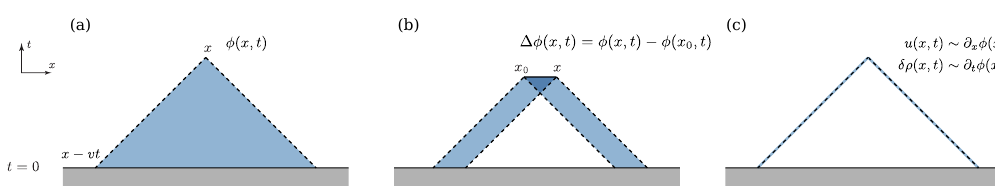
Figure 14: Schematic explanation of the equilibration time scaling in the canonical transmutation mechanism. Due to the linear dispersion of the TLL liquid, the phase field propagates according to the wave equation, meaning that it depends on initial data in the interior of the past light-cone (a). However, the phase field is not a physical observable itself: It is only phase differences with respect to some reference ) (b) or derivatives of the phase field (c) (corresponding point ∆ φ ( x ) = φ ( x ) − φ ( x 0 φ and density field δ ˆ (cid:37) ∼ ∂ φ ) that to the hydrodynamic fields like the velocity ˆ u ∼ ∂ z t are well-defined observables. The propagation of these fields as derived from that of the phase field is constrained to remain localized in the vicinity of the light-cone edges. The time evolved correlations between two (or more) such fields relax shortly after their initial-time spatial supports stop overlapping, which happens when the light-cone edges distance from each other, thus resulting in a linear scaling with time for phase differences and exponential scaling for derivative fields (c.f. Appendix